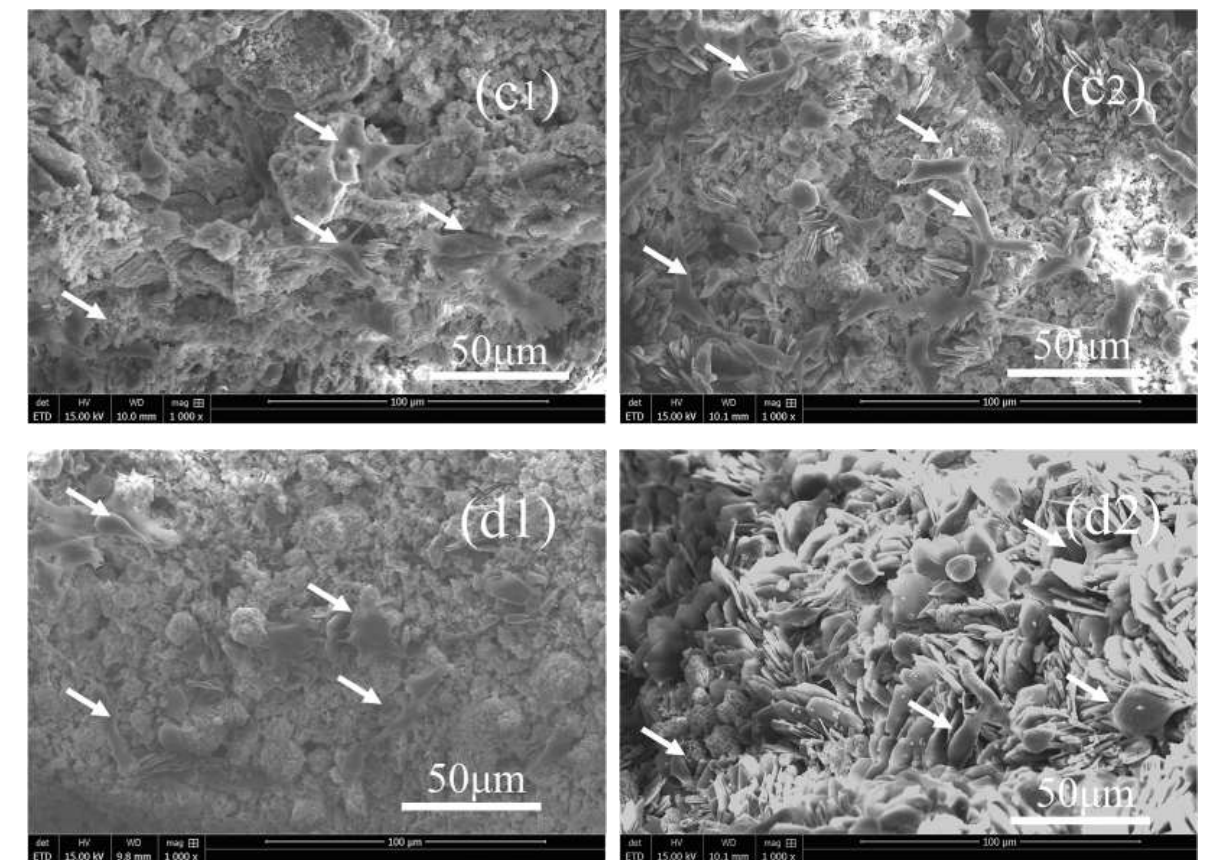
Figure 10. SEM images of the cell adhesion experiments of the porous composite scaffolds S0, S1, S3, and S5 ( a – d ) for 3 and 5 days. (a1), (b1), (c1), and (d1) for 3 days; (a2), (b2), (c2), and (d2) for 5 days.